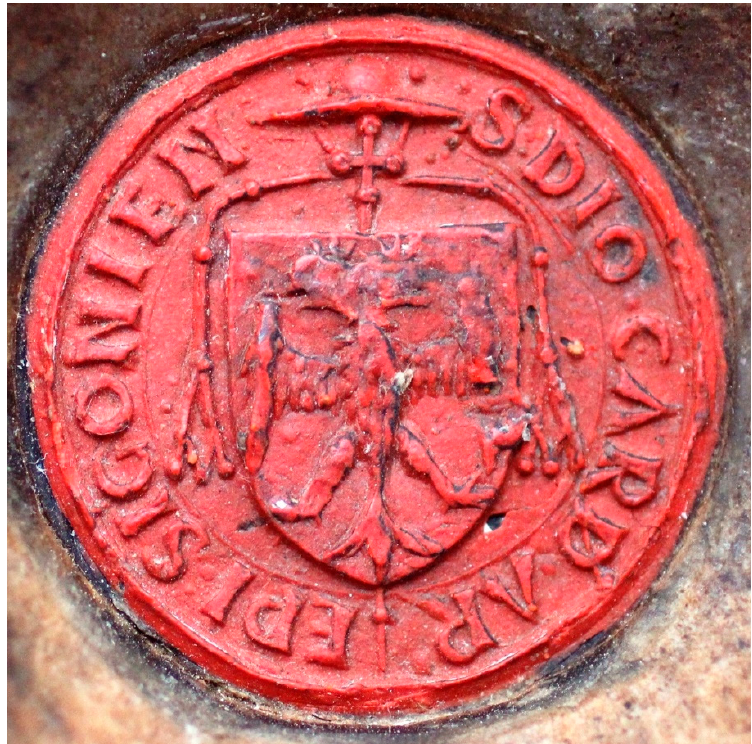
Figure 2. The seal of Cardinal Denis Szécsi, Archbishop of Esztergom, 1447. Haus-, Hof- und Staatsarchiv, Wien, Allgemeine Urkundenreihe 1447. VIII. 1. (Memoria Hungariae 2015, 21097.).